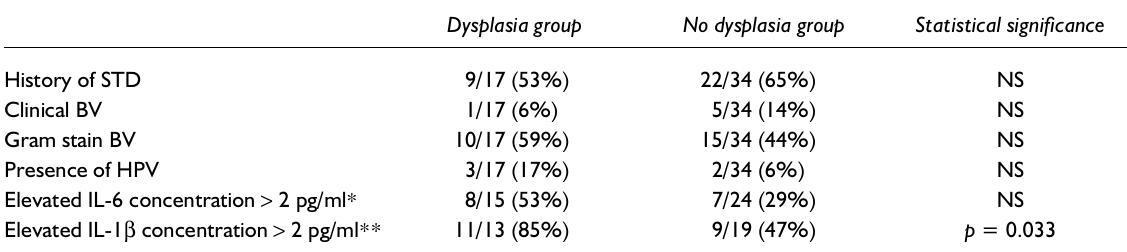
Table 2 Comparison of categorical variables between dysplasia and no dysplasia